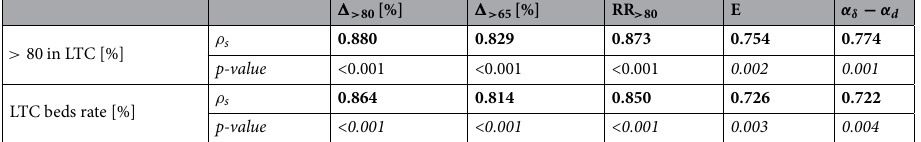
� > 80 [%] � > 65 [%] RR > 80 E α δ − α d ρ s > 80 in LTC [%]